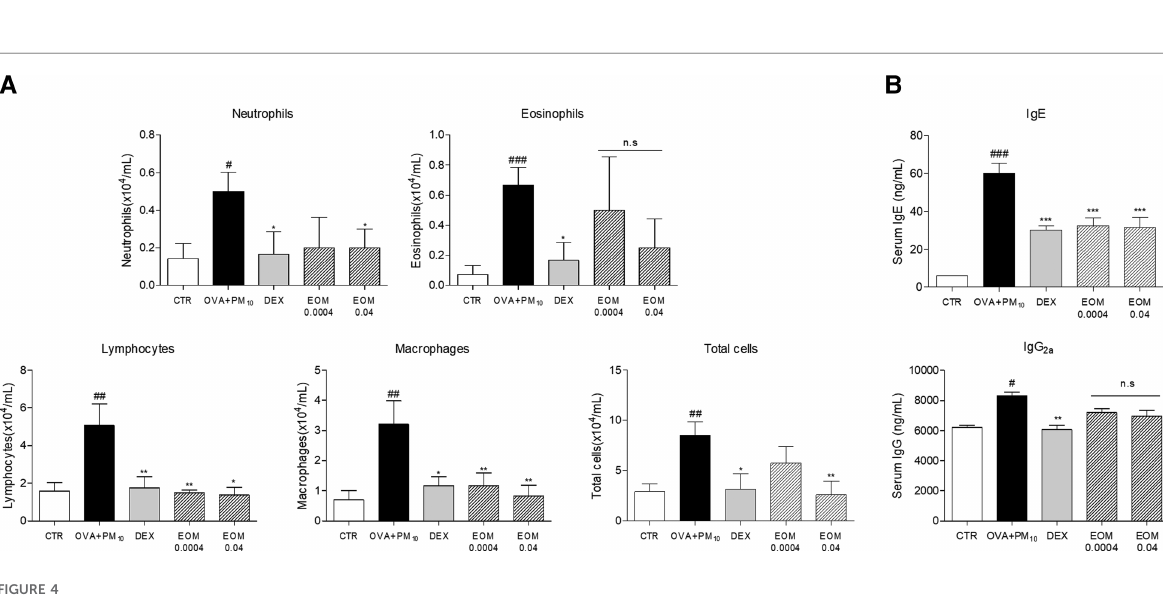
FIGURE 3 The effects of EOM on the nasal rubbing and sneezing symptom in OVA and PM10-induced model of allergic rhinitis ( A,B ). The nasal symptoms were evaluated after allergen challenge. EOM (0.0004, 0.04% v/v orally) was given to OVA and PM10-induced allergic rhinitis. Results are presented as mean±standard error of the mean. ### p <0.001 vs. CTR group; * p <0.05, ** p <0.01 and *** p <0.001 vs. OVA and PM10-treated group. CTR, control; EOM, essential oils from the Mentha piperita leaf ; OVA, ovalbumin.